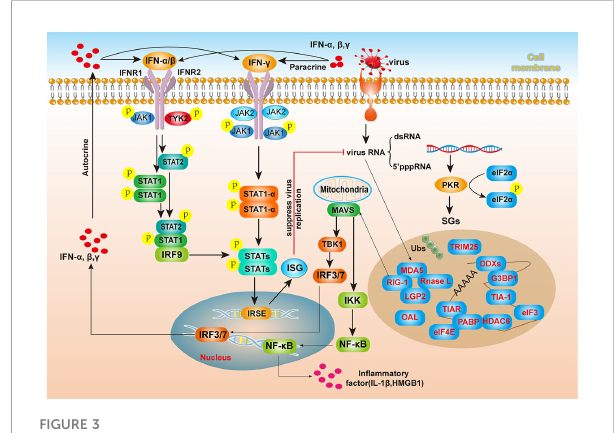
FIGURE 3 The relationship between SGs and antiviral innate immunity. After viral invasion into host cells, viral RNA (dsRNA or 5 ’ pppRNA) activates the PKR kinase, resulting in eIF2 a phosphorylation and SGs assembly. SGs contain the RIG-I-like receptors MDA5 and RIG-I, which can interact with MAVS on the mitochondrial membrane to activate the IFN signaling pathway and promote IFN production. After binding to IFN receptors on the cell membrane, interferon- stimulated genes (ISGs) induce the inhibition of viral RNA replication through the JAK/STAT pathway. After viral infection of cells, viral genomic RNA activates PKR, phosphorylates eIF2 a , and inhibits the initiation of translation, thereby inhibiting viral protein synthesis and inducing SGs formation. SGs are composed of diverse components, including viral RNA, RNA-binding proteins (RBPs), and translation initiation factors, and especially, many innate immune pattern recognition molecules, such as MDA5, RIG-I, LDP2, and RNase